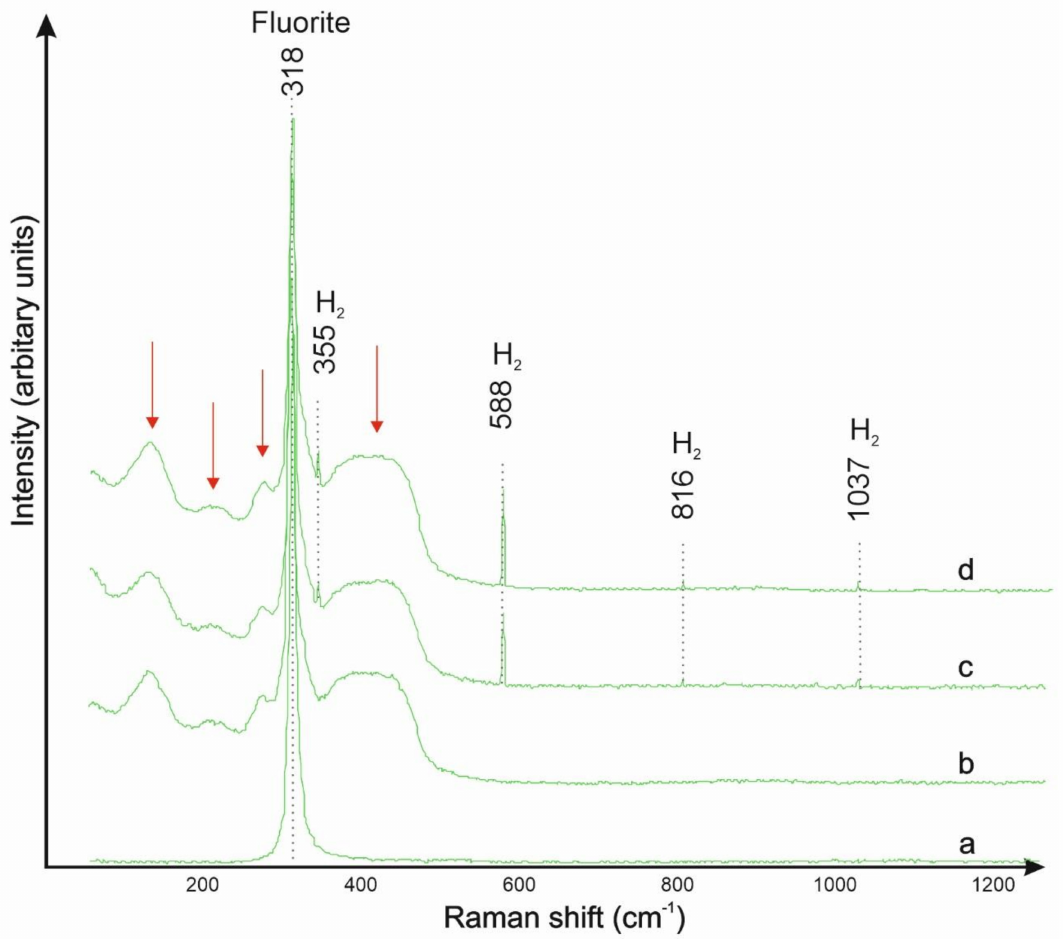
Figure 6. Results of Raman spectroscopy of fluid inclusions and fluorite. ( a ) Raman spectrum of ordered fluorite; ( b ) Raman spectrum of the liquid phase in a P inclusion in fluorite; ( c ) Raman spectrum of the vapor phase of a P inclusion showing the complex rotational band structure of H 2 . The Raman band of ordered fluorite is still present, while four other intensities indicate structurally disordered fluorite (indicated by red arrows); ( d ) Raman spectrum of the vapor phase of an S1 inclusion. The H 2 rotational bands are also